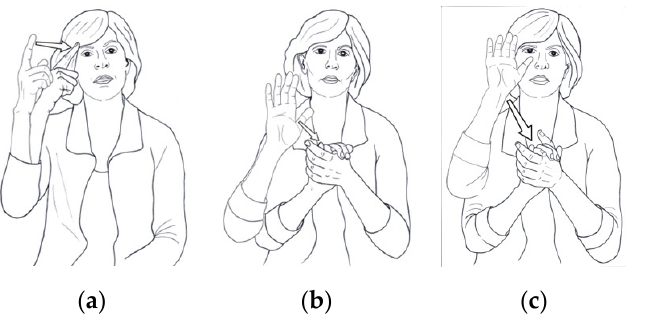
Figure 4. ASL compound. The constituents ( a ) THINK and ( b ) MARRY, and the compound ( c ) BELIEVE. Images courtesy of the Sign Language Research Lab, University of Haifa.